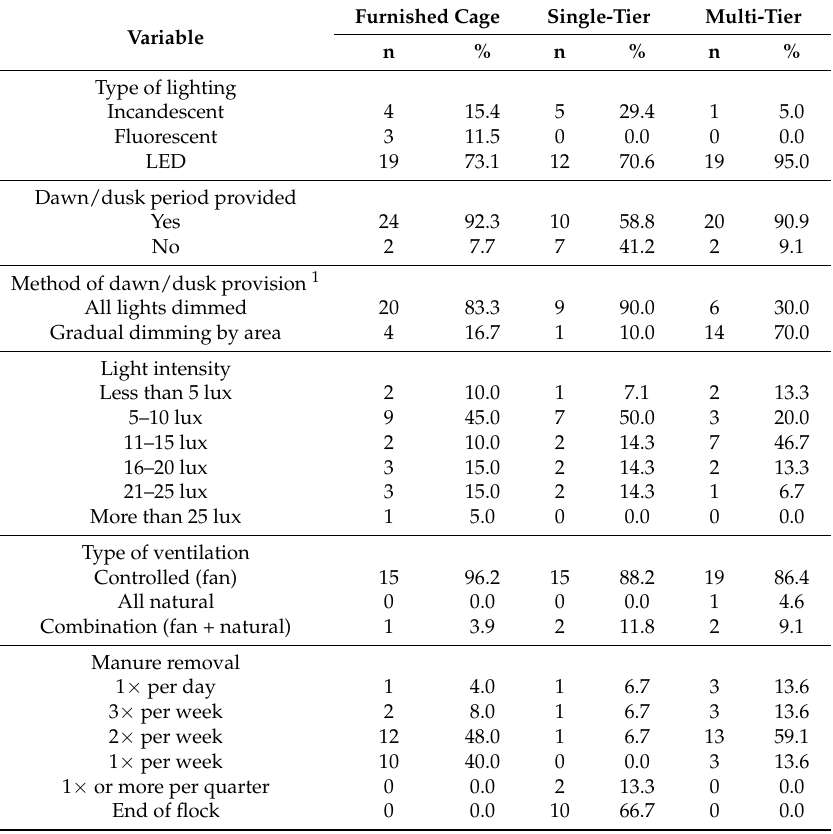
Table 5. Frequency of environmental control practices for 65 laying hen flocks placed between October 2016 and December 2017 according to housing system (furnished cage n = 26, single-tier n = 17, multi-tier n = 22) in